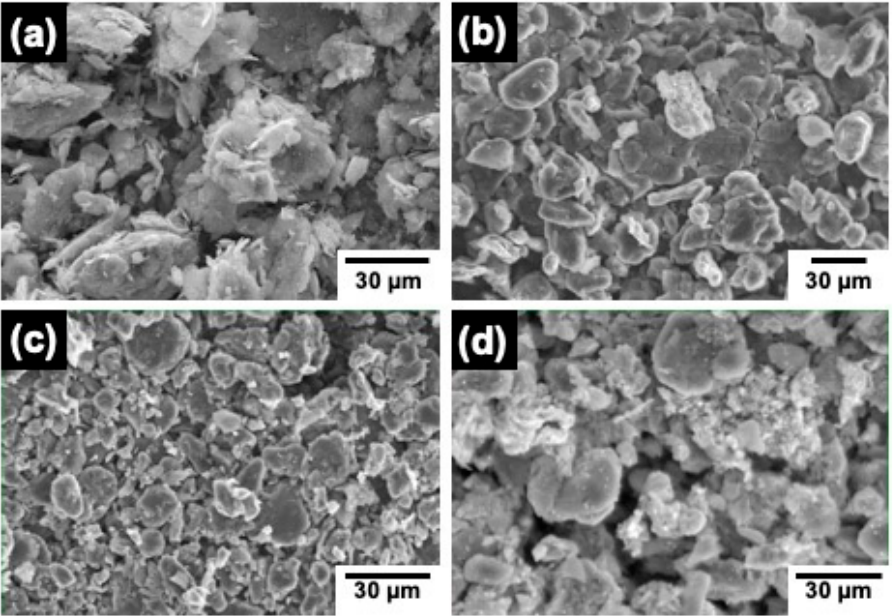
Figure 2. SEM micrographs representative of the investigated samples: ( a ) C-BBM, ( b ) C-SBM, ( c ) C-L 1 BM, and ( d ) C-L 2 BM. Table 4. Quantification of EDX analyses (normalized %wt) carried out in the final graphite samples.